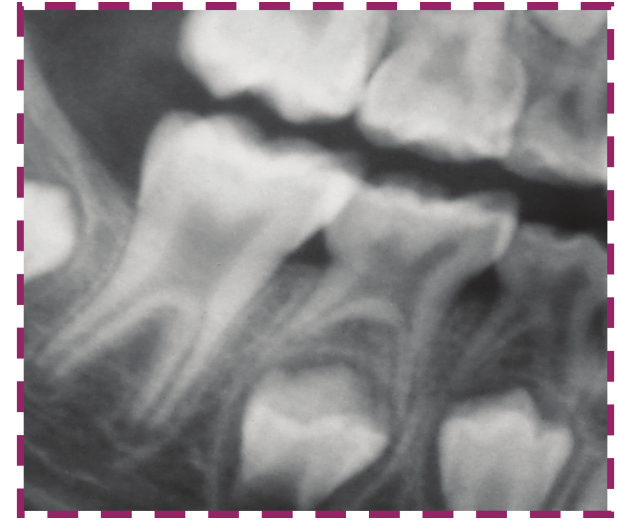
Figure 2 - Radiological aspect - patient with Hypophosphatemic